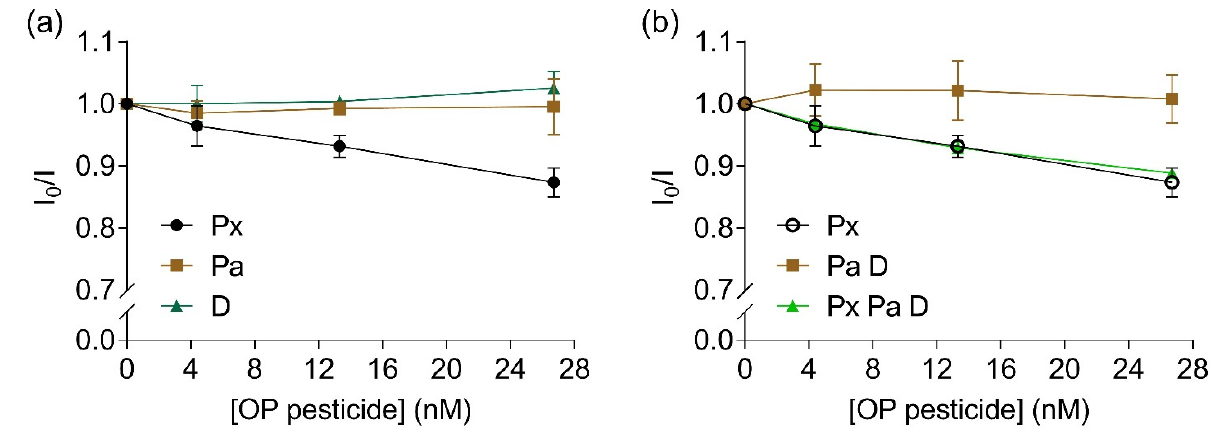
Figure 6. Ratios between the fluorescent intensity (mean ± SD, n = 3) of 67 nM IAEDANS-labelled EST2-S35C in the presence (I) and the absence (I 0 ) of increased concentrations (nM) of: ( a ) individual OPs paraoxon (Px, maximum of emission 458–462 nm), parathion (Pa, maximum of emission 452–462 nm) and diazinon (D, maximum of emission 451–462 nm); ( b ) paraoxon (repeated for comparison purposes), mixture of 1:1 parathion:diazinon (maximum of emission 458.5–462.5 nm) and mixture of 1:1:1 paraoxon:parathion:diazinon (maximum of emission 459–462.5 nm).